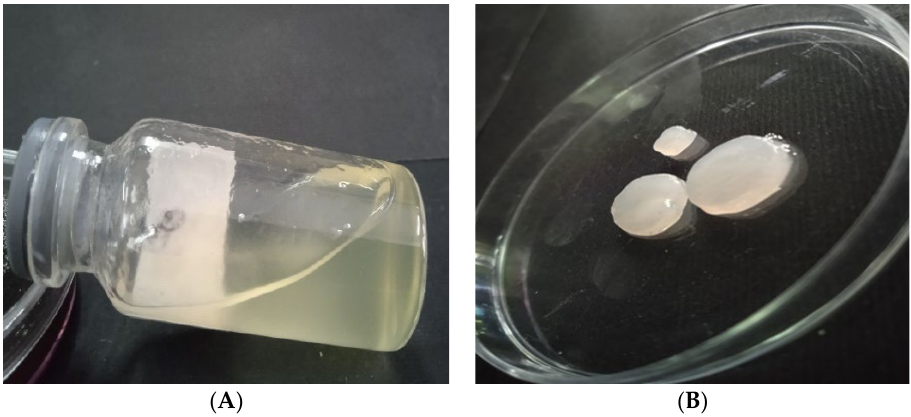
Figure 4. ( A ) Hydrogel in the form of gel, ( B ) Hydrogel film form.